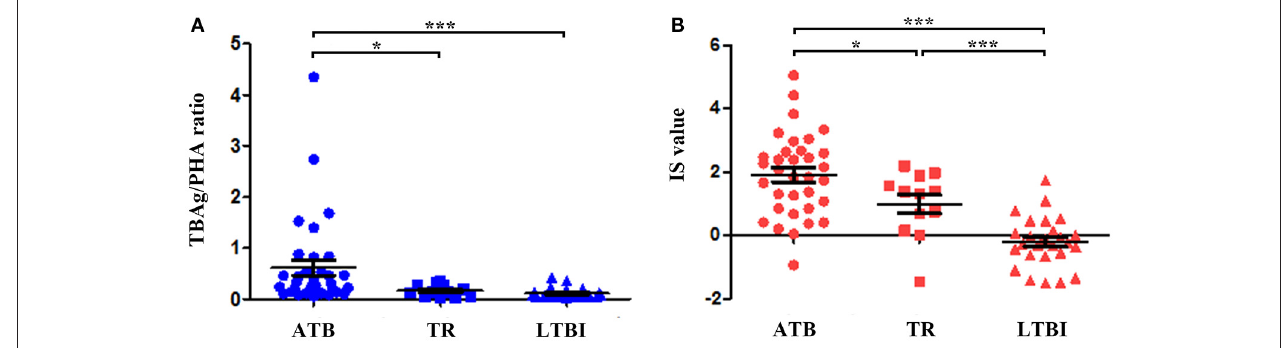
FIGURE 4 | The value of the TBAg/PHA ratio and IS model for monitoring anti-TB therapy. (A) Dot plots showing the TBAg/PHA ratio in different groups (ATB, TR, LTBI). (B) Dot plots showing the value of IS model in different groups (ATB, TR, LTBI). * p < 0.05, *** p < 0.001. Error bars indicate mean ± SEM. ATB, active tuberculosis; TR, the patients undergoing anti-TB treatment; LTBI, latent tuberculosis